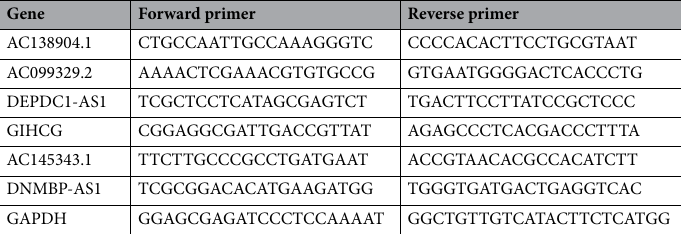
Table 2. The sequences of the qRT-PCR primers used in this study.